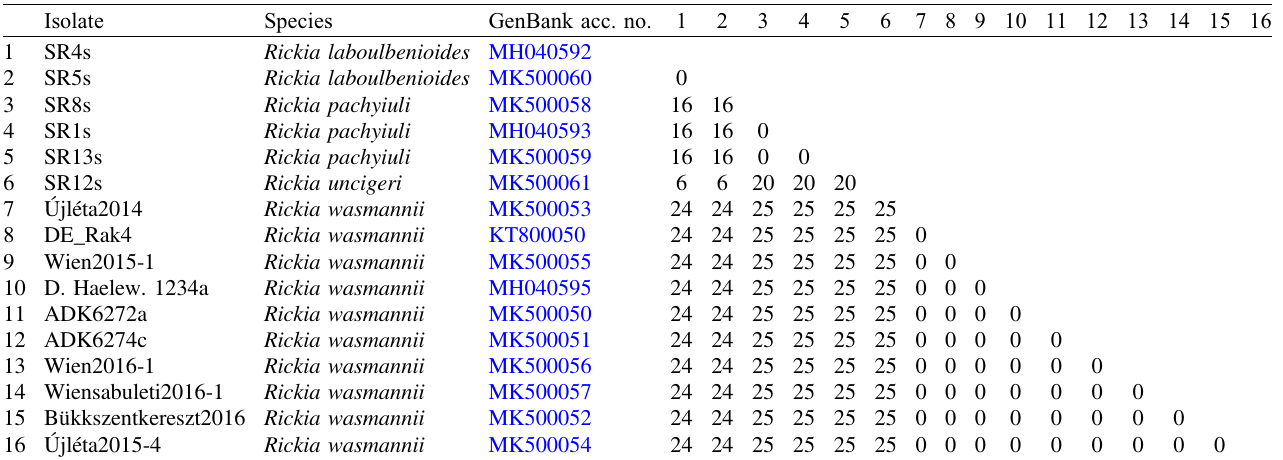
Table 7. Distance matrix of the aligned ITS